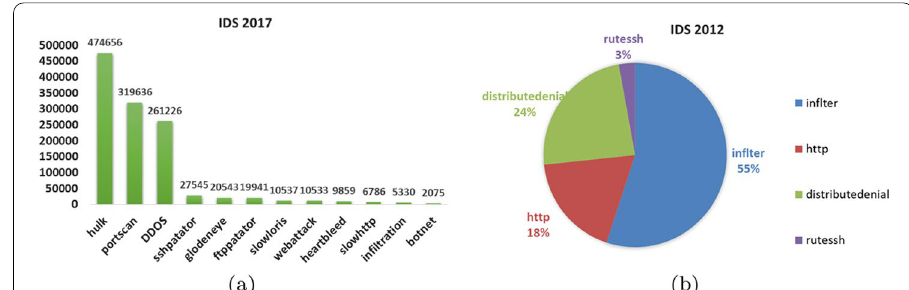
Fig. 5 Percentage of various types of traffic